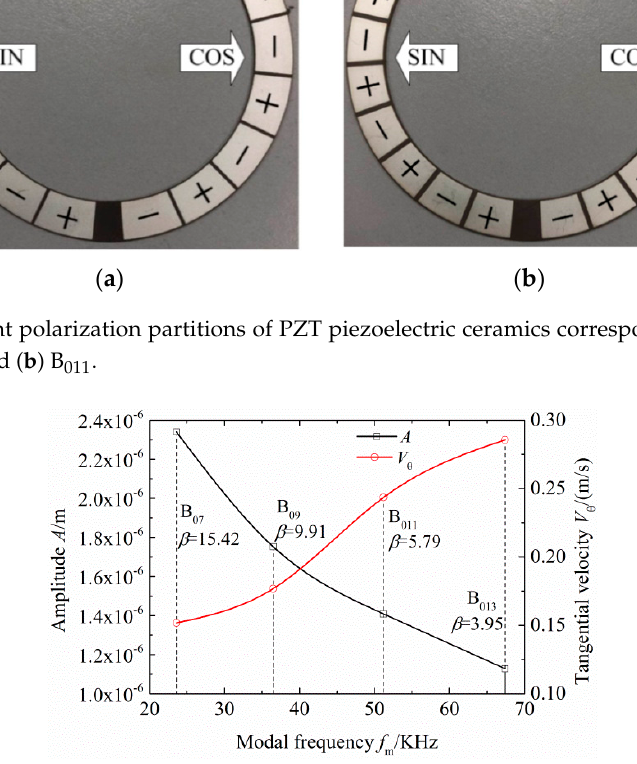
ff ected by operating modal Figure 6. Stator vibration parameters affected by operating modal order. Figure 6. Stator vibration parameters a Figure 6. Stator vibration parameters affected by operating modal order.